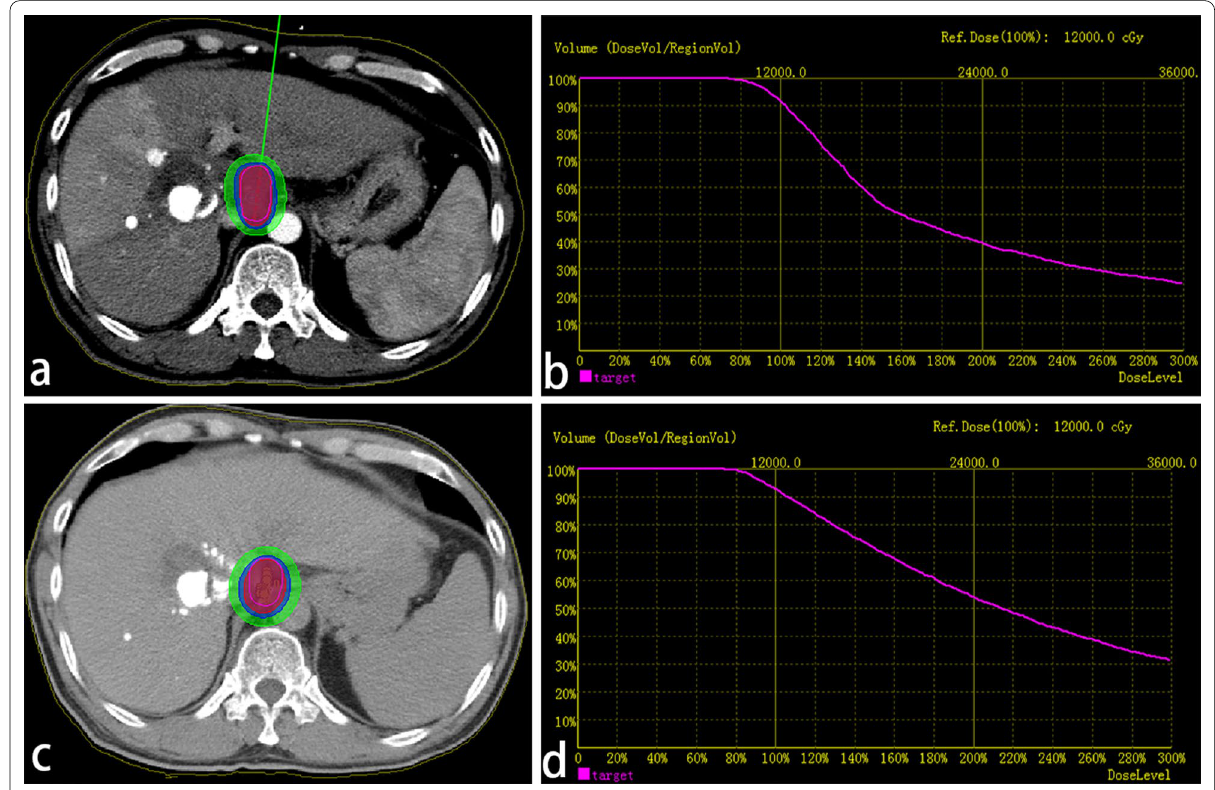
Fig. 1 a Preoperative TPS. The green straight line and the red area represent the puncture path and the gross tumor outline, respectively. b Preoperative dose-volume histograms (DVH). The prescribed dose (PD) was 120 Gy. 90% of the tumor volume received 123 Gy (D90 and 91.7% of the tumor target received 100% of the prescribed dose (V100 92.5%). c Postoperative practical radiation dose distribution. d = Postoperative DVH, D90 127.5 Gy, V100 92.8%. The postoperative practical radiation dose almost matches the preoperative radiation = =